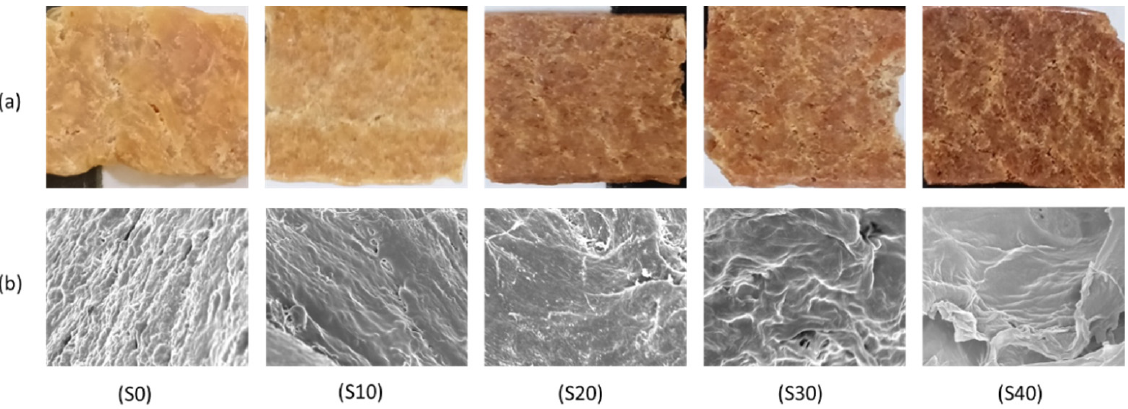
Figure 4. ( a ) Surface appearance and microstructure of the dried LMMA, and ( b ) freeze-dried rehydrated LMMA.